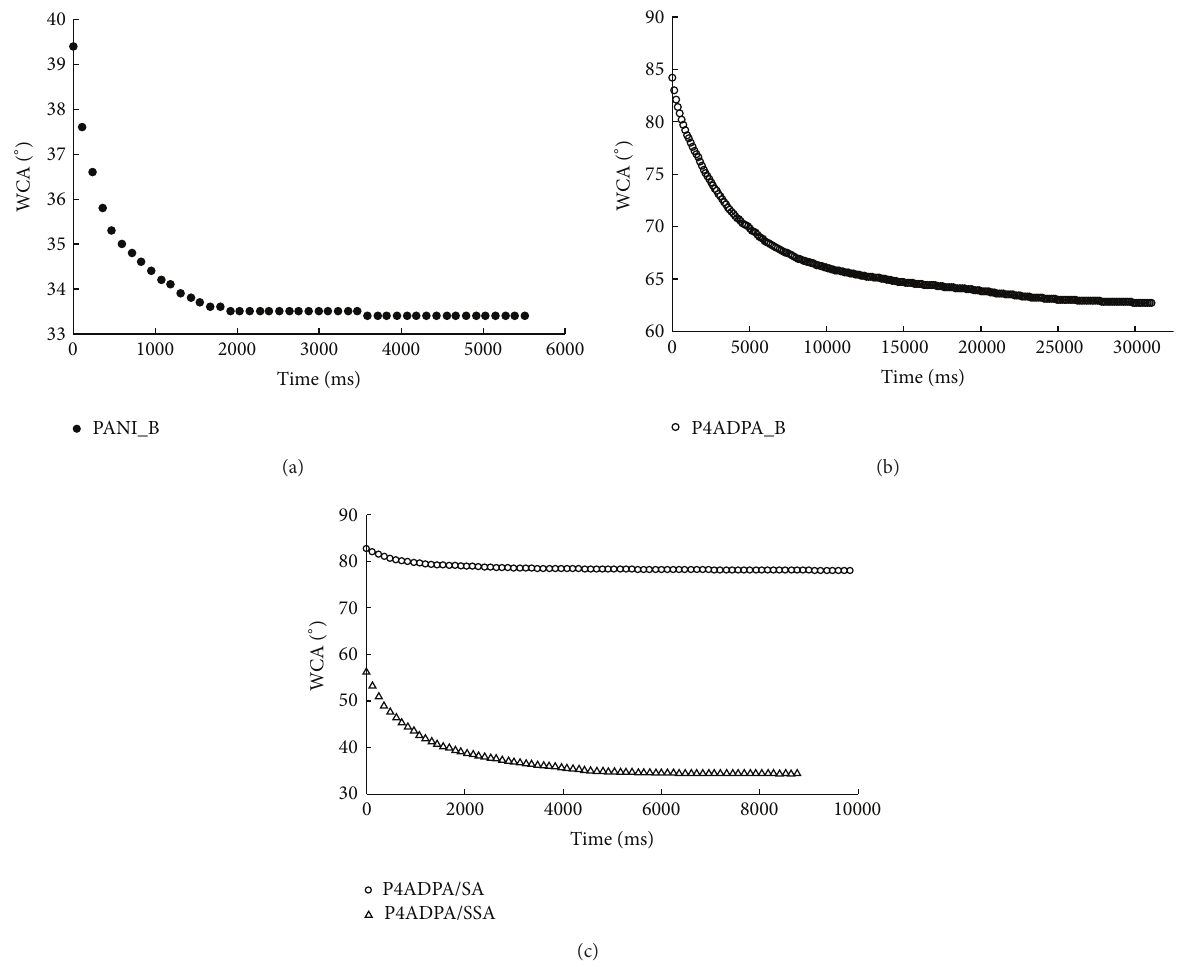
Figure 4: Variation of the contact angles measured on PANI B, P4ADPA B, P4ADPA/SA, and P4ADPA/SSA with the drop